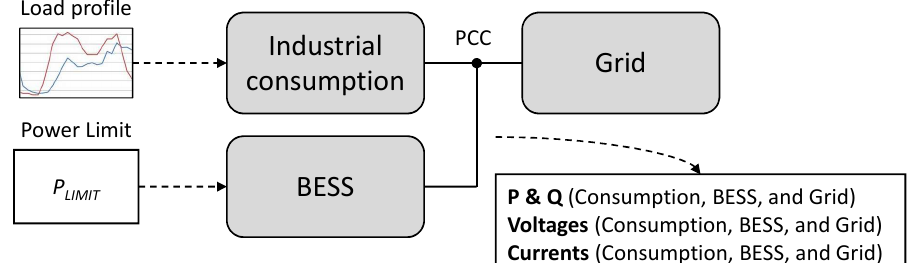
Figure 2. General model